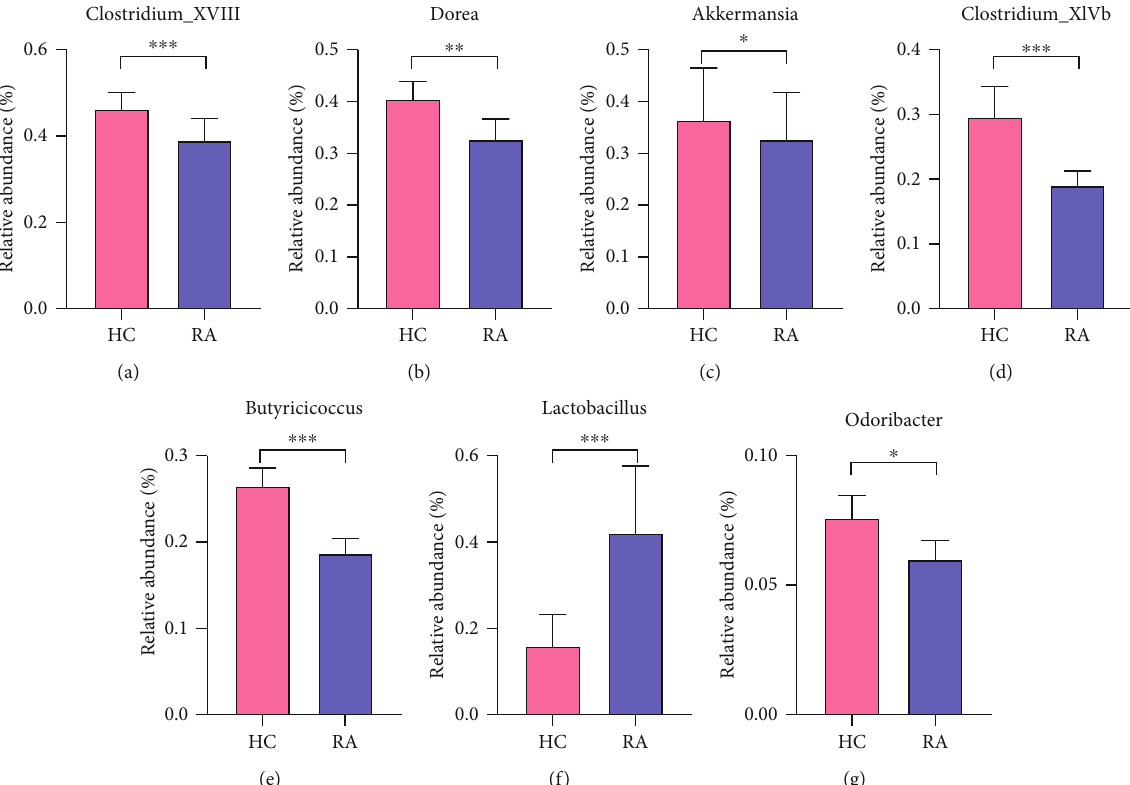
Figure 3: At the generic level, the relative abundances of some gut microbiome in healthy controls and RA patients were compared. Data were expressed as mean ± standard error of mean ( ∗∗∗ P < 0 : 001 , ∗∗ P < 0 : 01 , ∗ P < 0 : 05